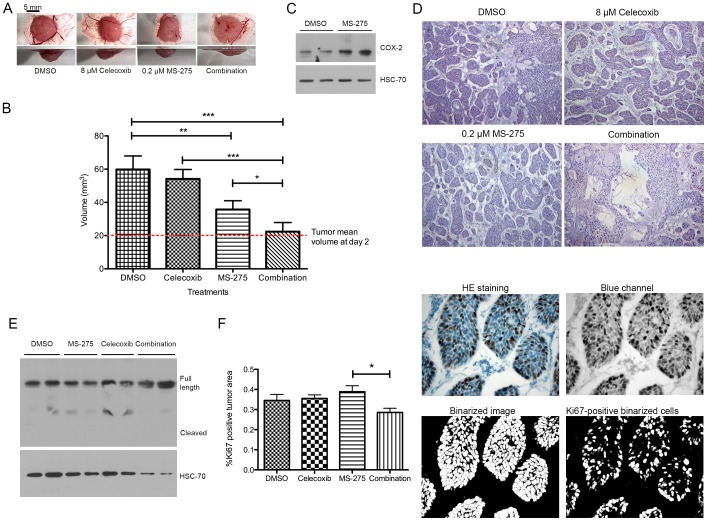
Effect of HDAC and COX-2 co-inhibition on BxPC-3 tumor growth on CAM.(A) Macroscopic pictures were obtained at the same magnification from bottom and side view. (B) Tumor volume at day 7 after cell implantation. Tumors were treated with 30 µl celecoxib (8 µM), MS-275 (0.2 µM) or drug combination at same concentration. (C) Western-blot detection of COX-2 in 20 µg proteins isolated from tumors grown on CAM and treated with MS-275 (0.2 µM). HSC70 was used as a loading control. (D) Histological aspect of tumors grown on CAM during 7 days and treated with 30 µl celecoxib (8 µM), MS-275 (0.2 µM) or drug combination at same concentration. (E) Western-blot detection of caspase-3 in 40 µg proteins isolated from tumors grown on CAM and treated with MS-275 (0.2 µM) or celecoxib (8 µM). HSC70 was used as a loading control. (F) Ki67 immunostaining and associated quantification of tumors grown on CAM during 7 days and treated with 30 µl celecoxib (8 µM), MS-275 (0.2 µM) or drug combination at same concentration. Results are expressed as mean ± s.d. ***P<.001, **P<.01, *P>.05. n≥3 in each condition.